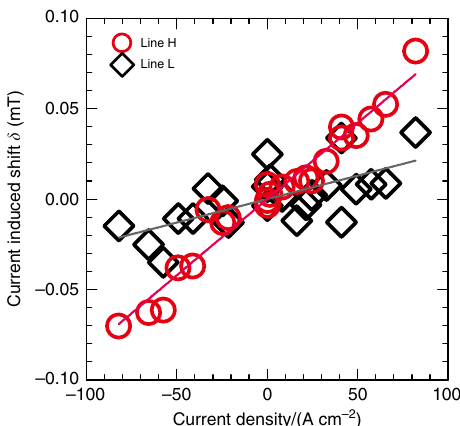
Fig. 4 Current density dependence of current-induced shift. Red circles and black diamonds indicate the current-induced shift δ (mT) for line H and line L, respectively. The proportionality coef fi cient obtained by least-squares fi tting is 8.4( ± 0.4) × 10 − 4 mT A − 1 cm 2 for line H and 2.6( ± 0.6) × 10 −